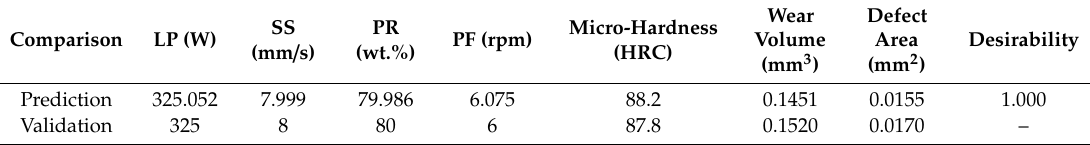
Table 8. Comparison between the predicted optimization result and experimental validation.